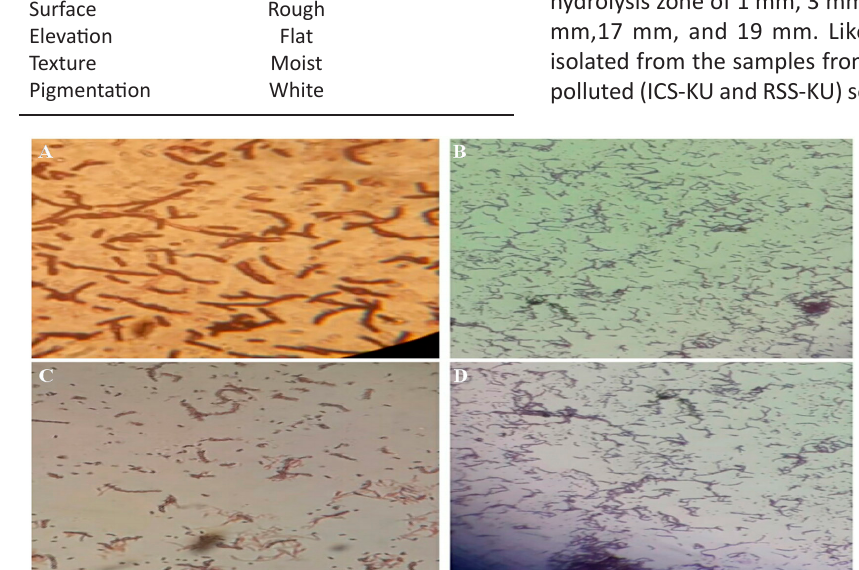
Fig. 1. Representation of the microscopic investigations for the bacterial